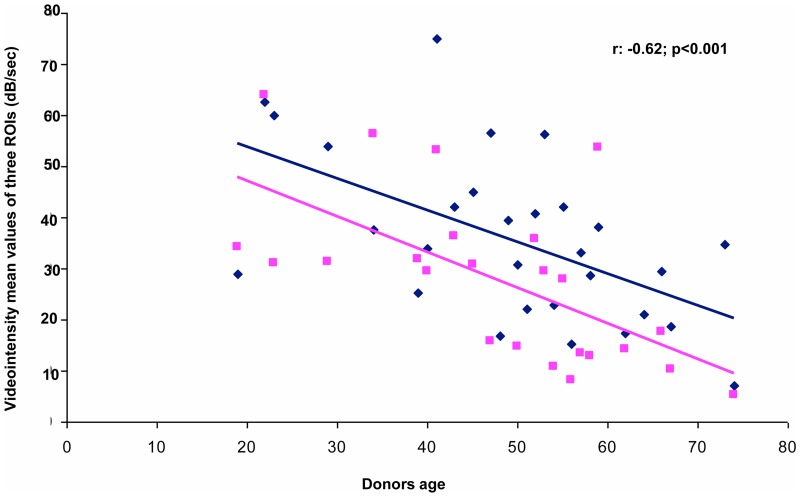
Significant relationship between donor age and CCBF level at 48 h(square points), and the average CCBF value over the whole follow-up (diamond points; r, -0.62; p<0.001).